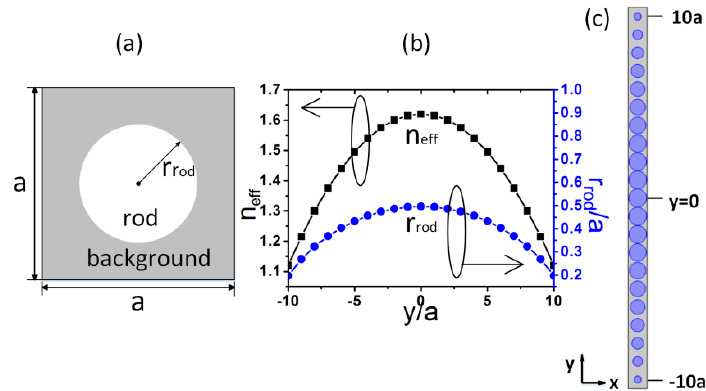
Figure 1. ( a ) The unit cell consists of rod and background; ( b ) Curves of effective refractive index and dielectric rod radius varying with Y direction ( c ) Schematic diagram of single layer structure.